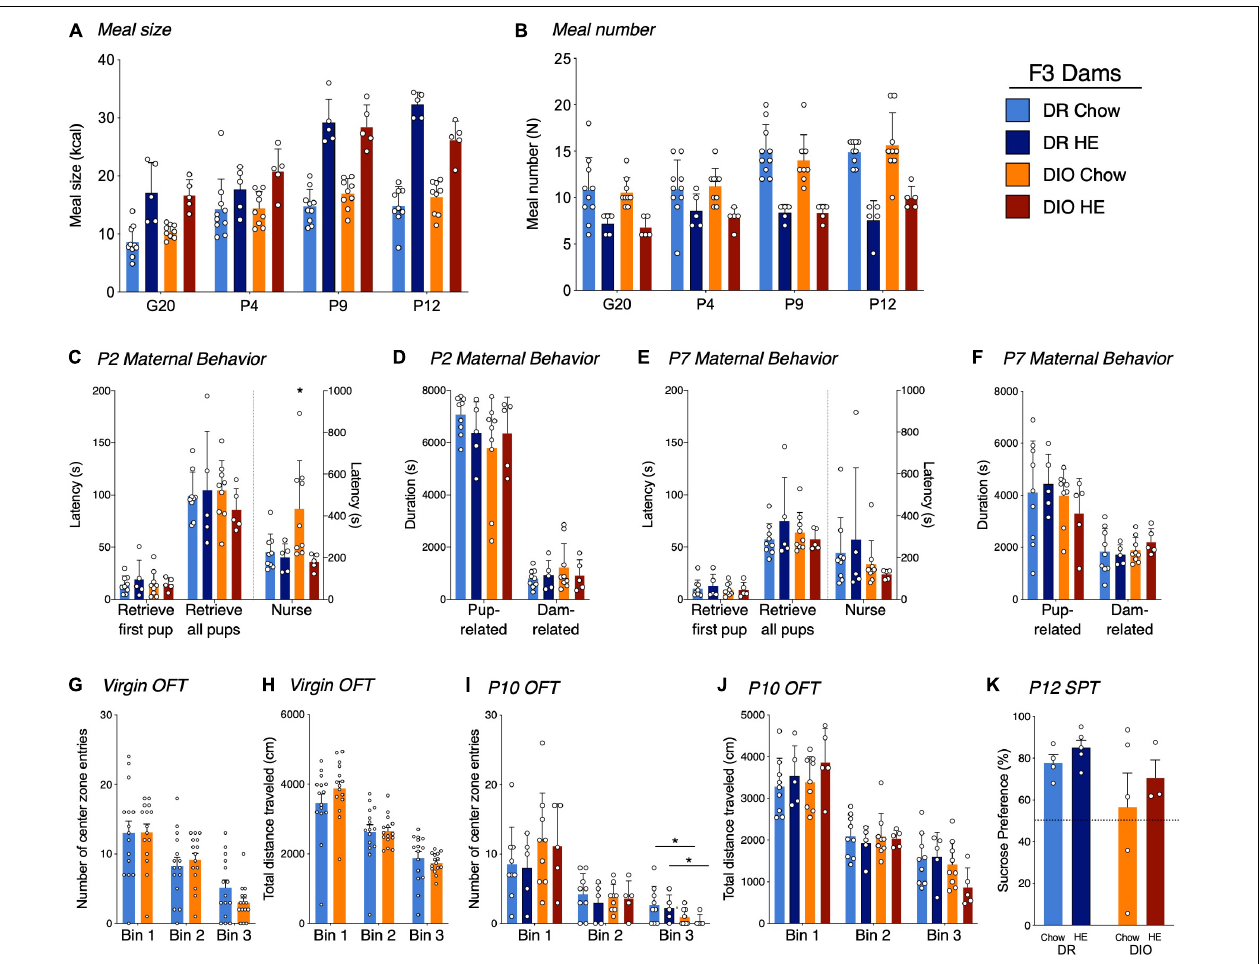
FIGURE 5 | Influence of HE-diet in diet resistant (DR) and diet induced obese (DIO) rat dams in filial generation 3 (F3) on meal pattern, amylin sensitivity and maternal behavior. Average meal size in kilocalories (A) and meal number (B) of pregnant and postpartum DR and DIO rat dams on chow or high energy (HE) diet on G20, P4, P9, and P12. (C–F) Maternal behavior in DR and DIO dams on chow or HE diet on P2 or P7. Latency to retrieve first pup, latency to retrieve all pups and latency to start nursing in seconds on P2 (C) and P7 (E) . Total duration in seconds of pup-related and dam-related behavior on P2 (D) and P7 (F) . (G,H) Open field test in virgin DR and DIO rat dams around 9 weeks of age on chow. (G) Number of center zone entries divided into 3 bins, where one bin represents 5 min. (H) Total traveled distance in centimeter (cm) in virgin DR and DIO dams per bin. (I,J) OFT on P10 in DR and DIO rat dams on chow or HE diet. Number of center zone entries (I) and total traveled distance in centimeter (J) divided into 3 5-min bins. (K) Sucrose preference in percent of total liquid intake on P14–15 in DR and DIO rat dams on either chow or HE diet. Data are represented as mean ± SD. * P < 0.05. DR-chow ( N = 10), DR-HE ( N = 5), DIO-chow ( N = 9), and DIO-HE ( N = 5).